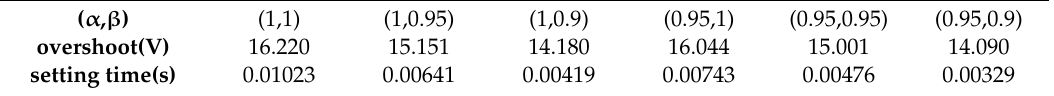
Table 2. The overshoot and setting times of the output